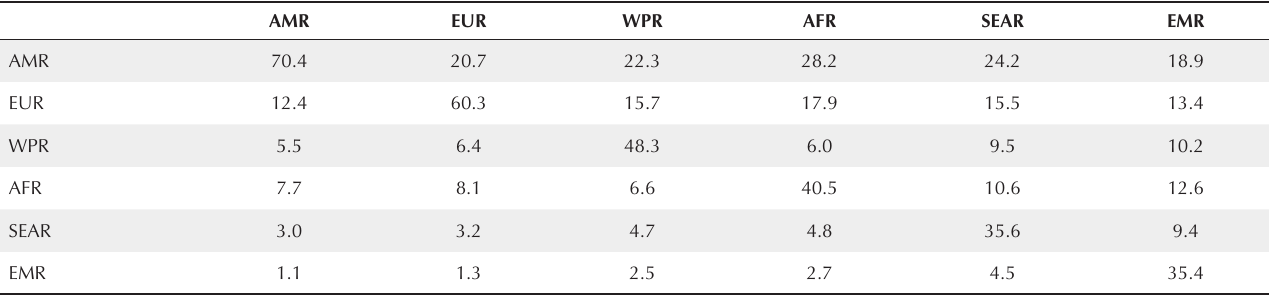
Table 4. Collaborative Publications (%) Within and Between WHO Regions